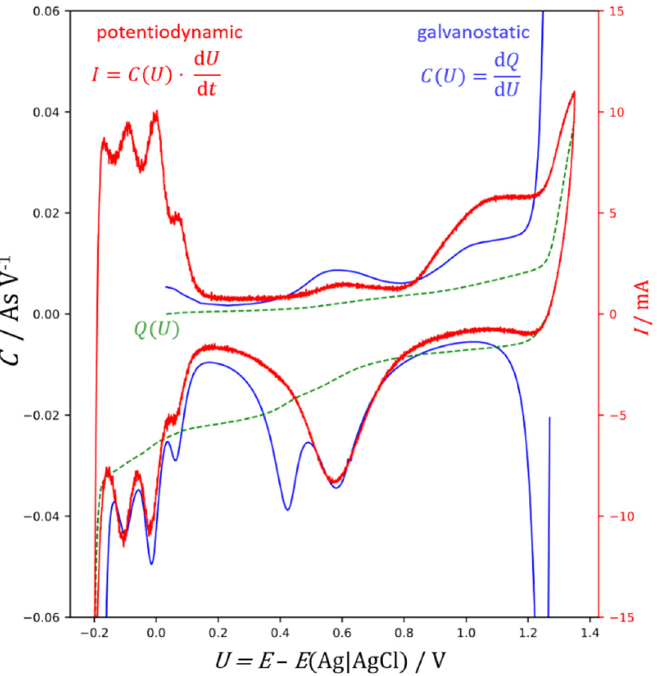
Figure 5. Cyclic voltammogram of a platinum electrode (red) in sulfuric acid against a silver–silver chloride reference electrode (red: differential capacitance C = I / v , scan rate v = 250 mV/s) compared to d Q /d U from constant current charge–discharge curve (blue: cut-o ff current at 1.35 V and − 0.2 V).